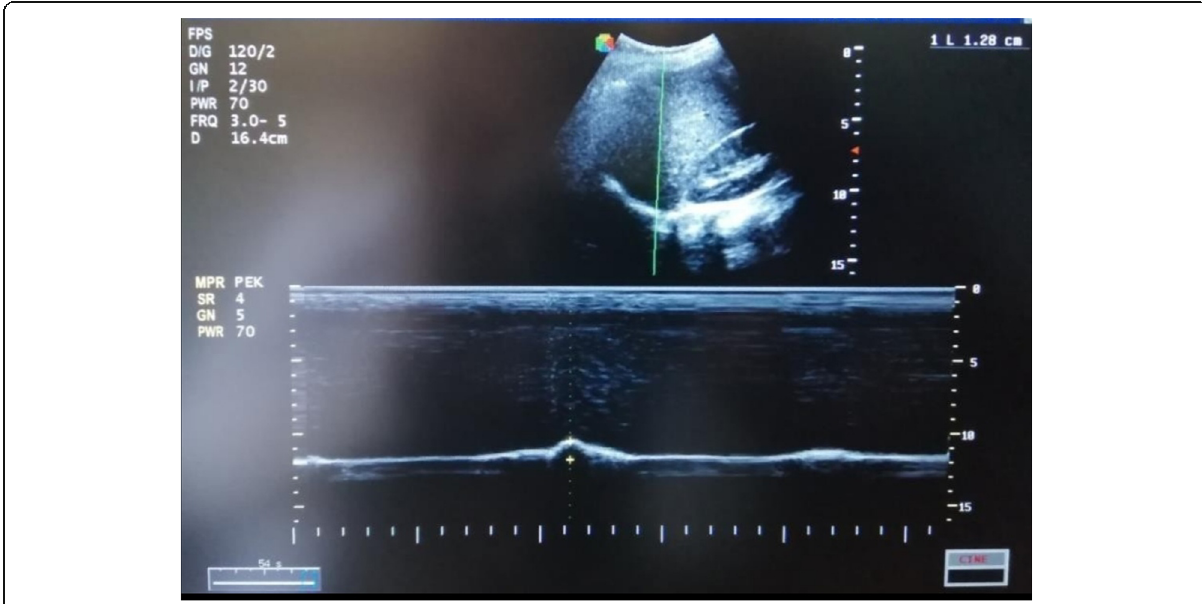
Fig. 3 Ultrasound measurement of diaphragmatic right tidal